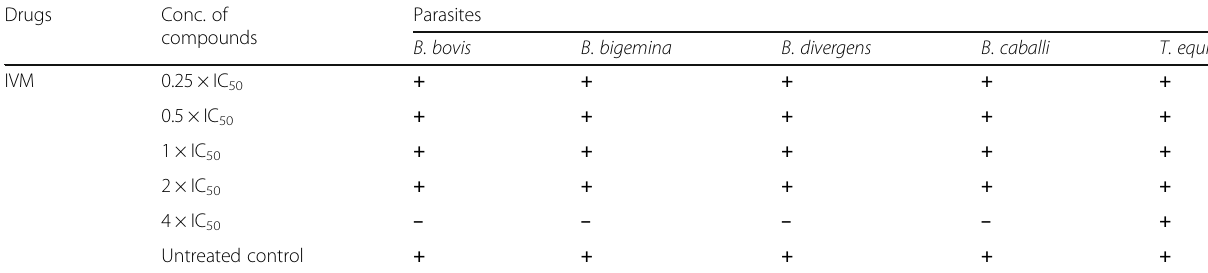
Table 2 The viability of Babesia and Theileria parasites treated with IVM Drugs Conc. of